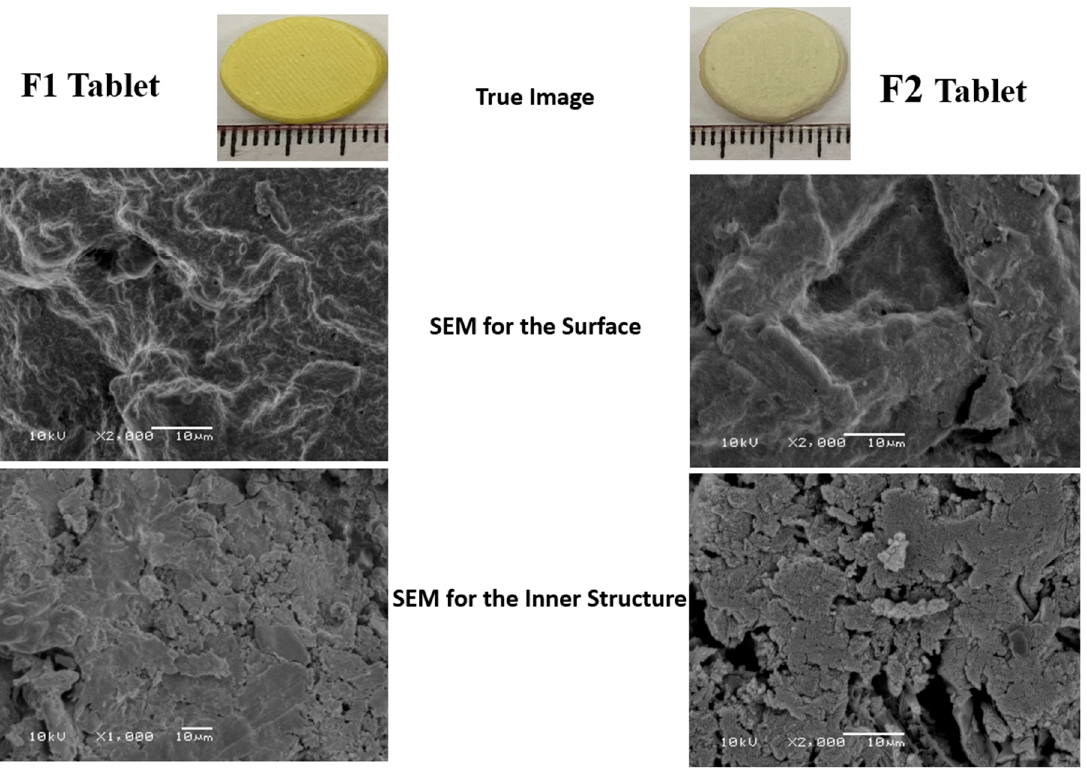
Figure 2. Images and SEM photographs for the surface and inner structure of SNEDDS-based ( F1 ) and non-SNEDDS ( F2 ) based 3DP tablets.